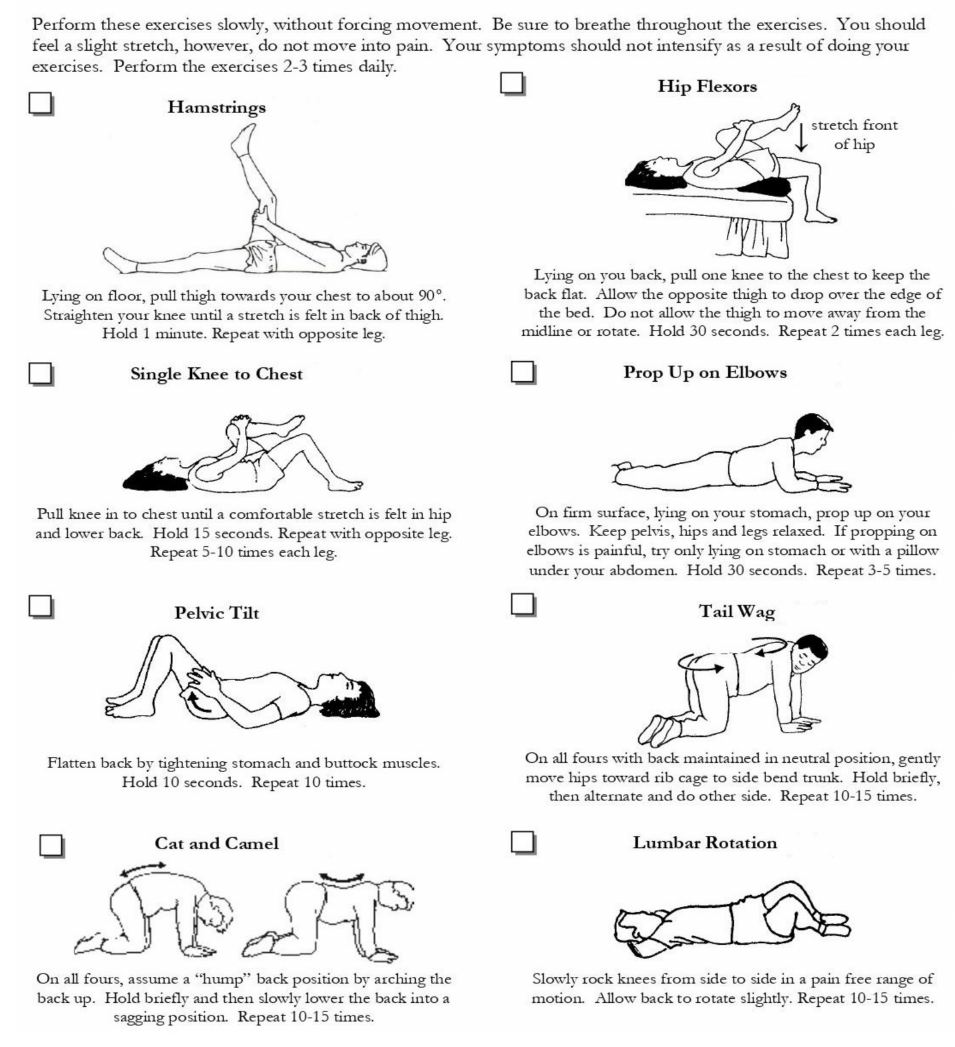
Figure A1. Basic exercises for the low back